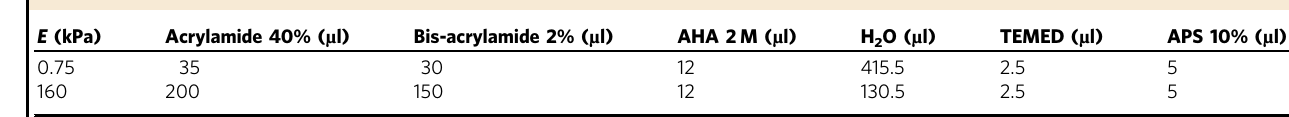
Table 1 Hydrogel recipes for 48 mM co-factor